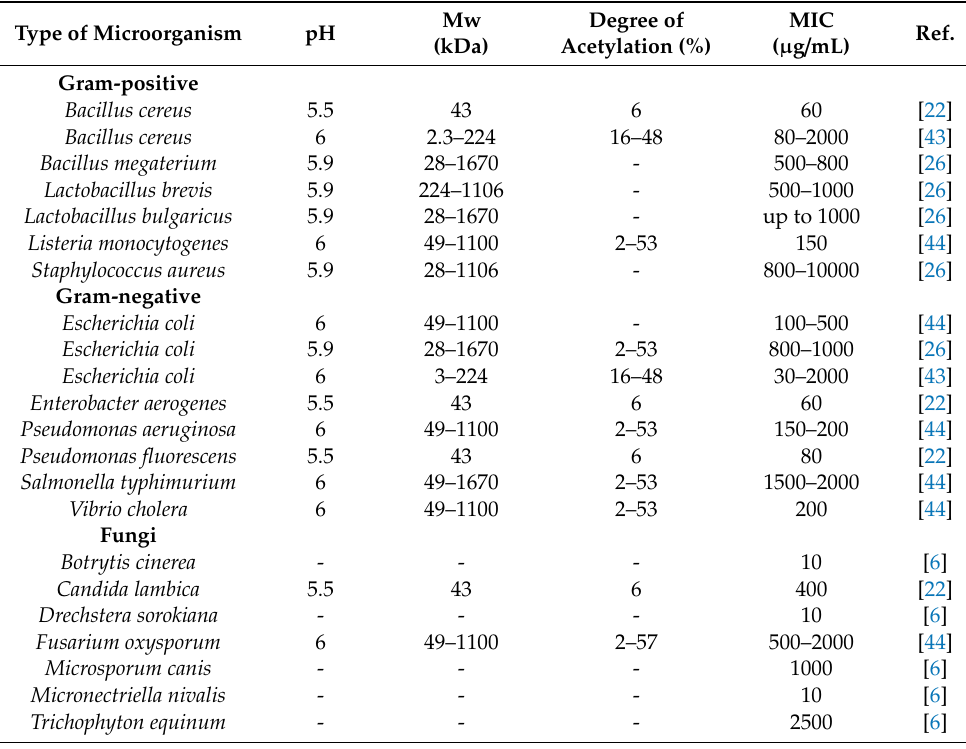
Table 3. Minimal inhibitory concentration (MIC) of chitosan against three types of